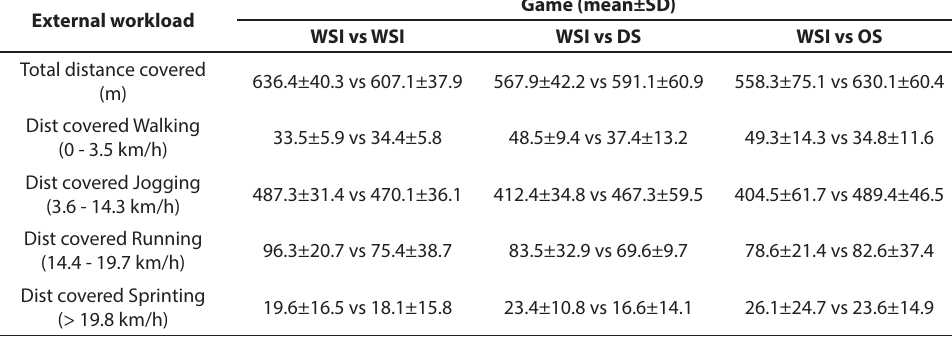
TABLE 3 Descriptive results from the comparisons among considered game scenarios for external